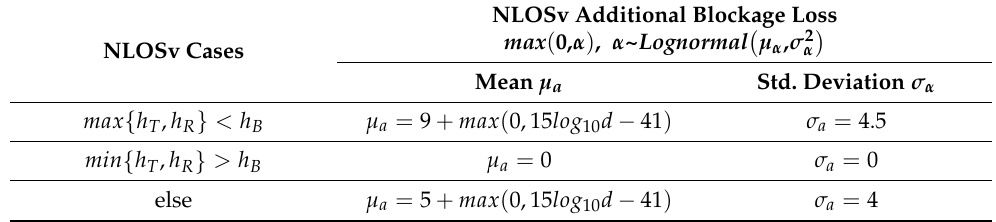
Table 4. Large-scale fading in V2X communication models.